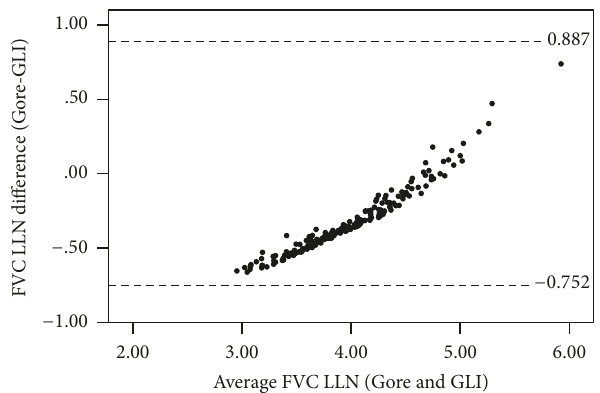
Figure 3: Differences between FVC LLN for Gore compared with GLI illustrating the lower LLN for GLI, particularly for lower values ( 𝑁 =